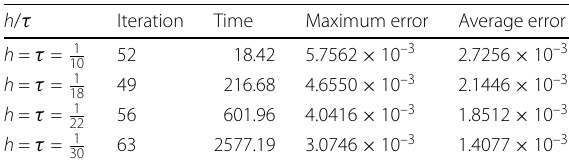
Table 8 The number of iterations, execution times (in sec) and errors of C–N high-order finite difference method for Test problem 1, when γ = 0.1